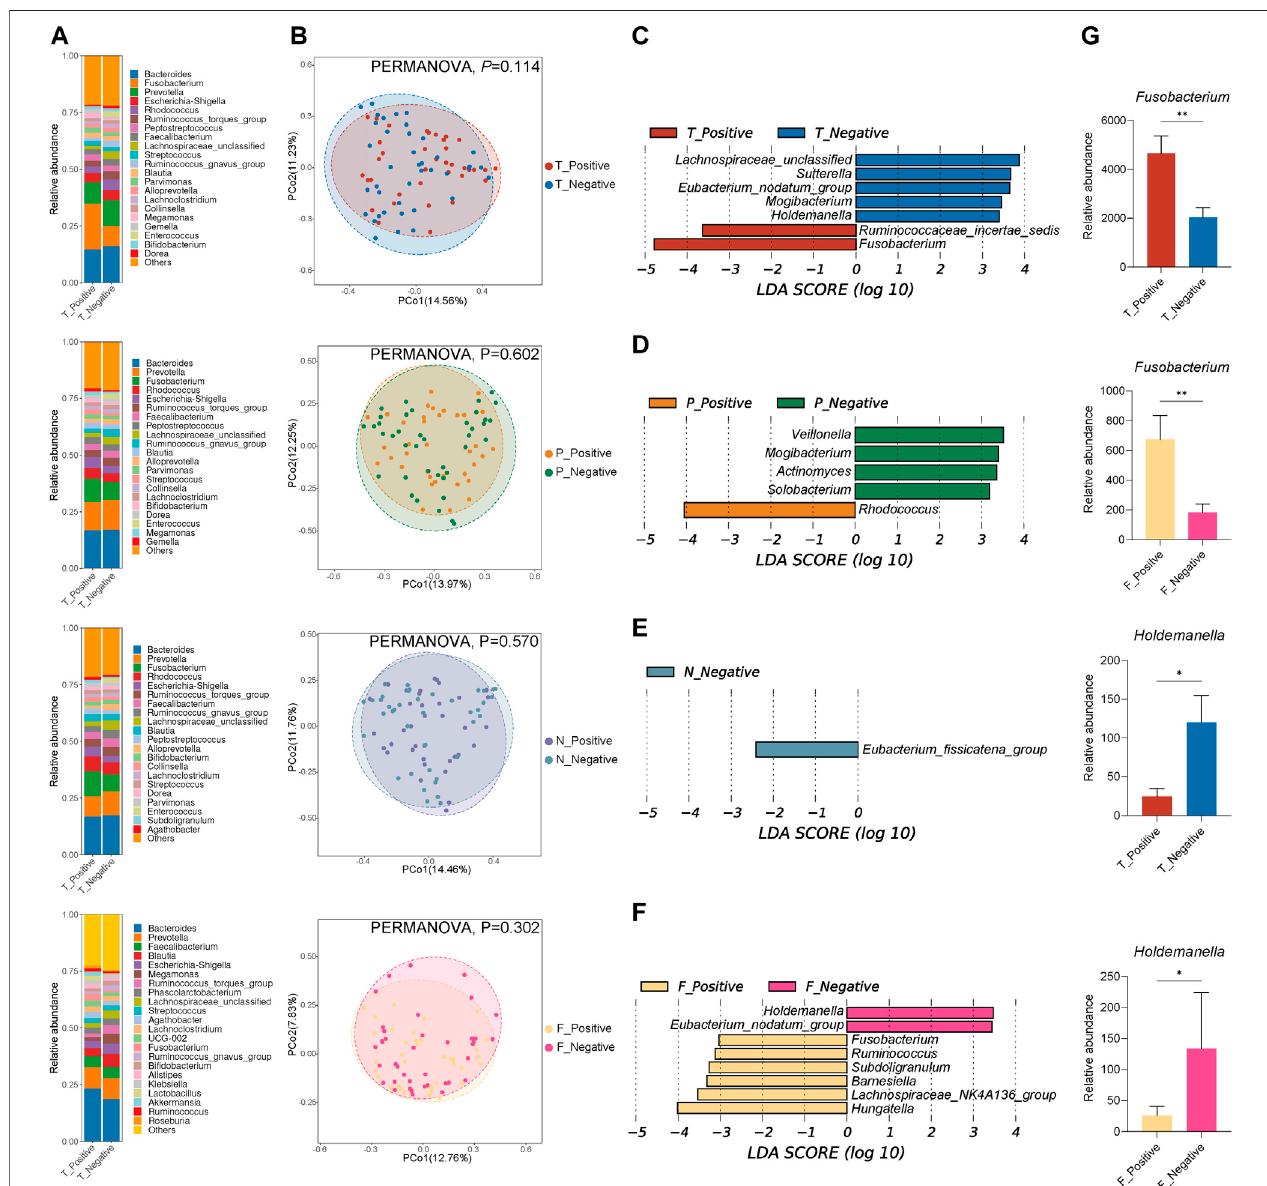
FIGURE3 | Microbial community ecology differsbetween theFOBT positive and FOBT negativegroups at tumor mucosa (T), para-cancerous mucosa (P), normal mucosa(N),andfeces(F)sites. (A) Relativeabundance(%)ofgeneraintheFOBTpositiveandFOBTnegativegroups. (B) Comparisonof β diversityusingPCoAanalysis basedonbray-curtisdistancewithstatisticalsigni fi cancedeterminedbyPERMANOVAbetweentheFOBTpositiveandFOBTnegativegroupsatdifferentsamplingsites (C – F) Histograms of LDA scores ( > 2.0) for differentially abundant genera between the FOBT positive and FOBT negative groups at different sampling sites. (G) Relativeabundanceof Fusobacterium and Holdemanella intheFOBTpositiveandFOBTnegativegroupsoftumormucosaandfeces.* p < 0.05,** p < 0.01,*** p < 0.001, **** p < 0.0001.